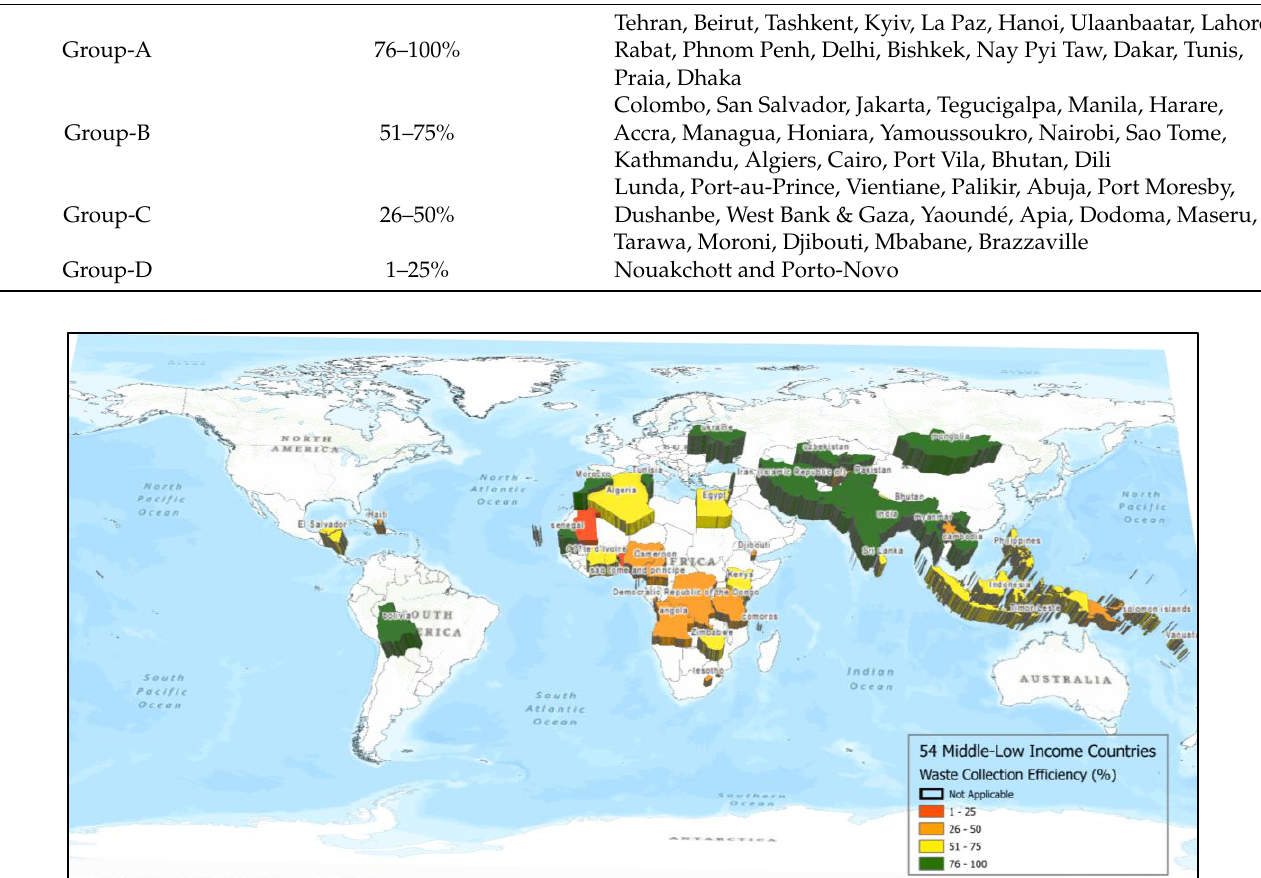
Figure 4. Waste collection efficiency map of low –middle‒income countries/cities.